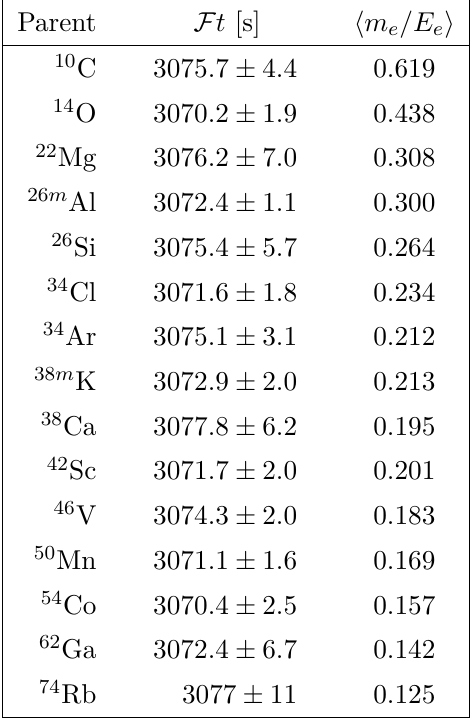
Table 8 . Data from superallowed decays used in the fits [60].